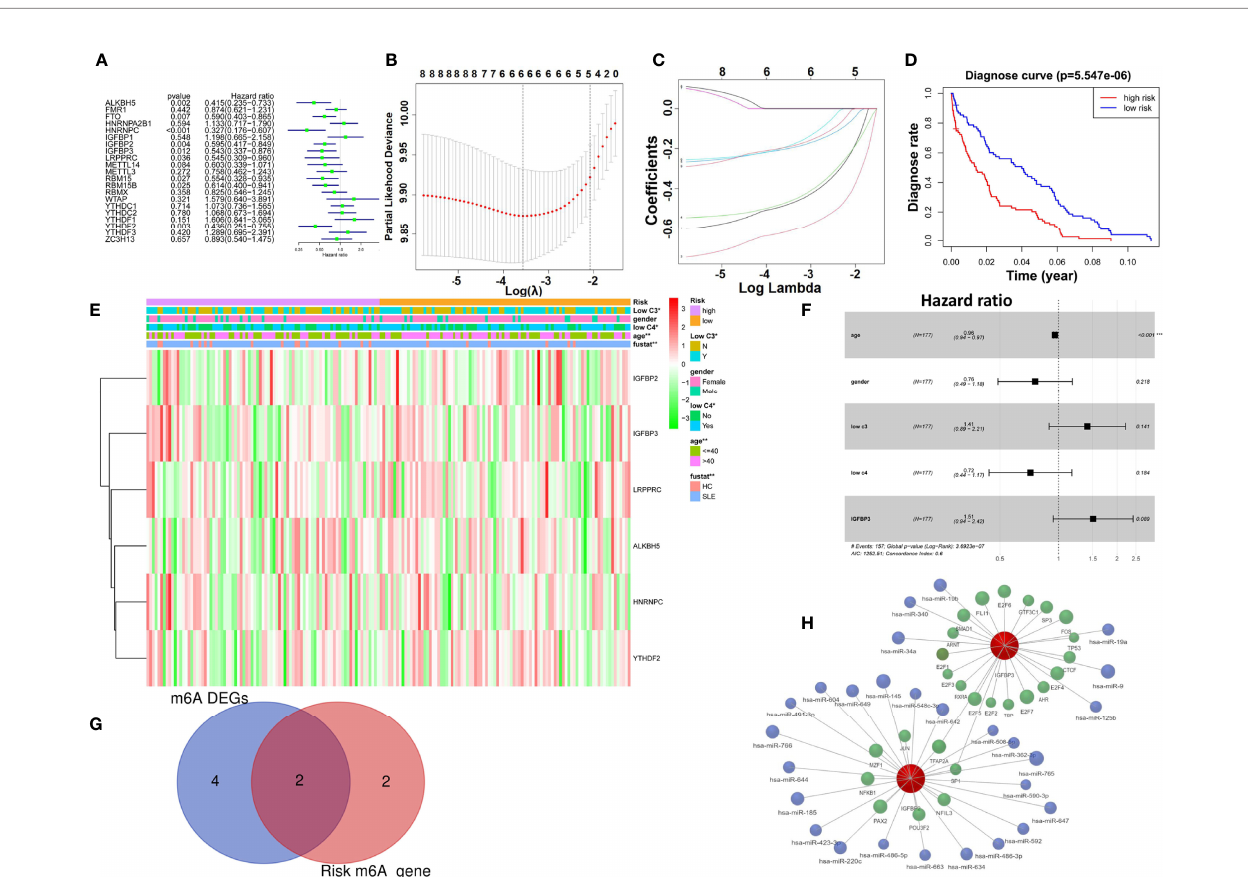
FIGURE 4 | The diagnostic signature can distinguish healthy and SLE samples, and a TF – miRNA network of m6A regulators was constructed in GSE49454. (A) Univariate logistic regression demonstrated the relationship between m6A regulators and diagnosis. (B) LASSO coef fi cient pro fi les of m6A regulators. (C) Tenfold cross-validation for tuning parameter selection in the LASSO regression. (D) KM plots presenting diagnoses in the high- and low-risk sets. (E) Heatmap for the connections between clinicopathologic features and risk factors. (F) Multivariate Cox regression model analysis, which included the factors of age, sex, low c3, low c4, and IGF2BP3 in the GSE49454 dataset. (G) Venn diagram to identify differentially expressed m6A risk genes. (H) TF – miRNA coregulatory network of two m6A regulators (pink: m6A risk genes; blue: miRNA; and green: TF genes). *p < 0.05;**p < 0.01;****p <